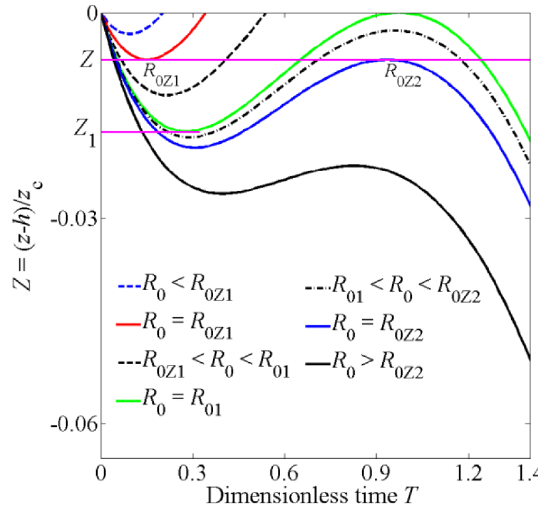
Figure 4. Movement curves of ice particles near the upper bound- ary. The particles with initial radius R 0 Z 1 move upward after turn- ing back at the Z height (the red line), and the particles with initial radius R 0 Z 2 move downward after turning back at Z (the blue